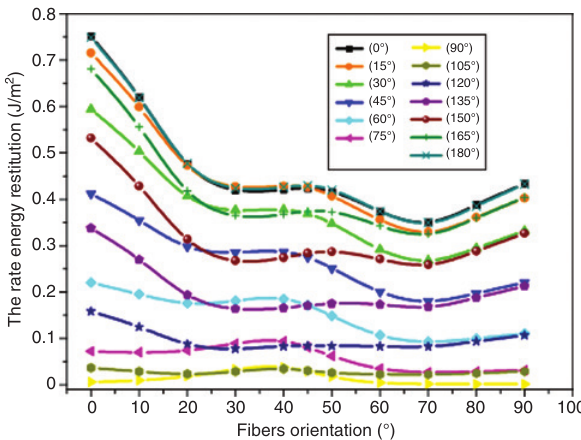
Figure 10 illustrates the variation of G factor as a function of the two angles α and β and an orientation angle circular notches γ = 45 ° . It is noted that the curves are almost similar to that of Figure 8 but the symmetry factor G with respect to the Y axis is not maintained except for the angles of the fibers ranging from 60 ° to 90 ° . It is noted that the speed of propagation of the crack is greater when it is oriented at an angle β = 0 and this is regardless of the fibers’ orienta- tion. Note also that the orientation of the plies at an angle of 70 ° results in a low crack propagation.